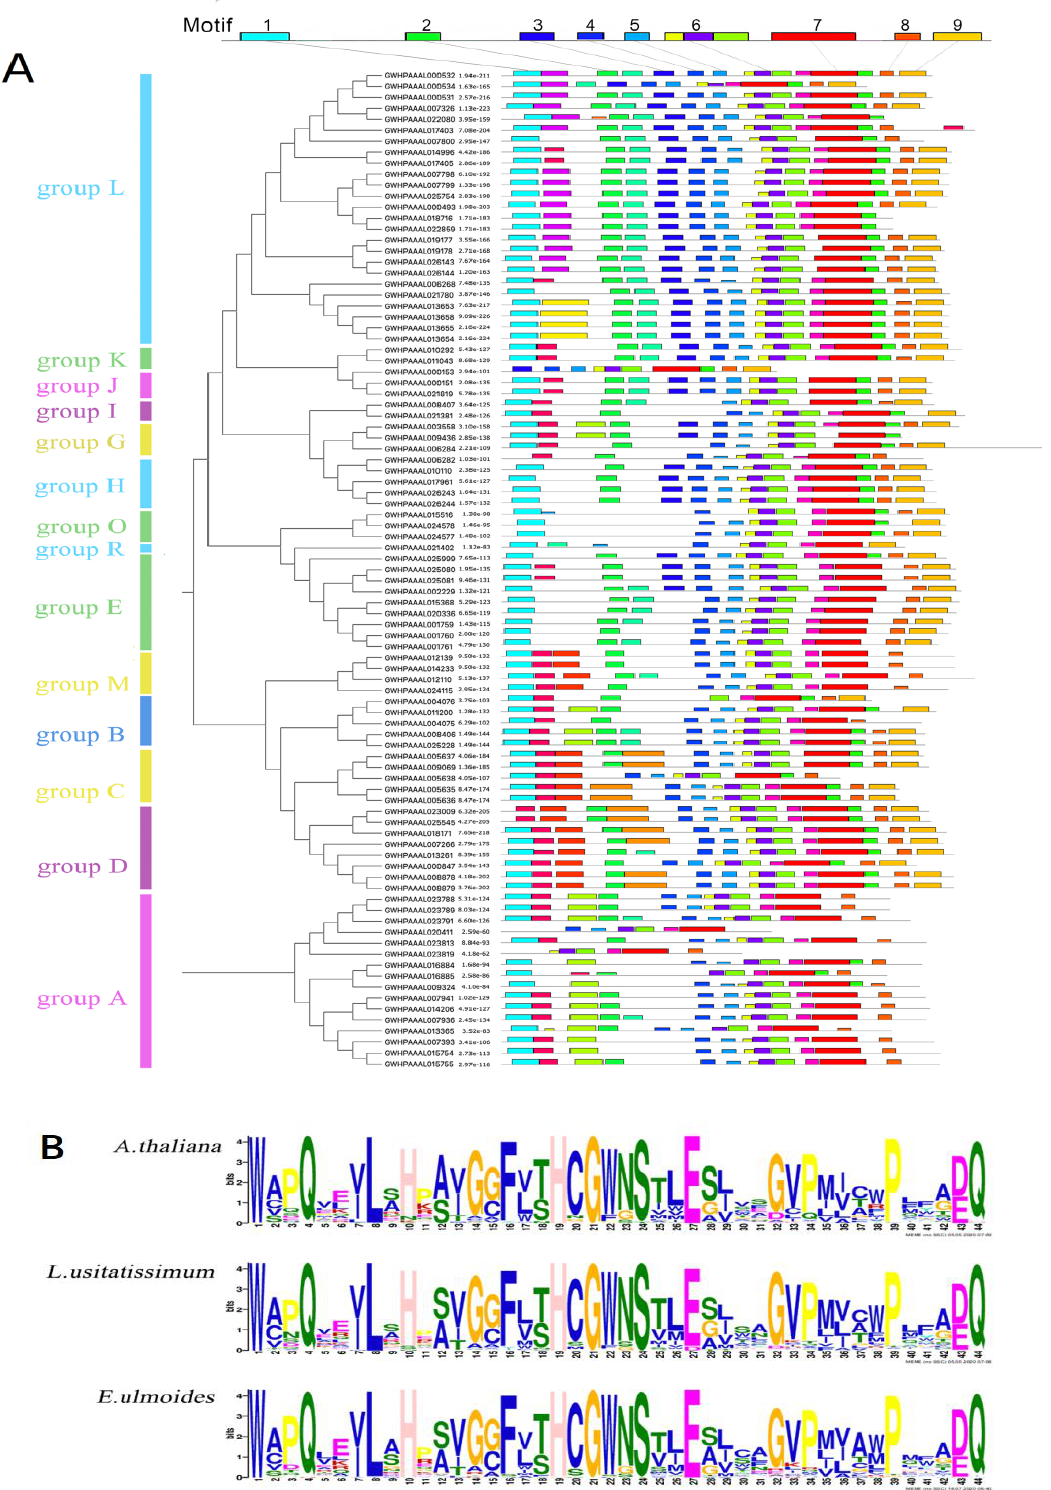
Figure 2. Conservative motifs of Eu UGTs ( A ) and the Weblogo of PSPG box (motif 7) within the UGTs in A. thaliana , L. usitatissimum , and E. ulmoides ( B ).